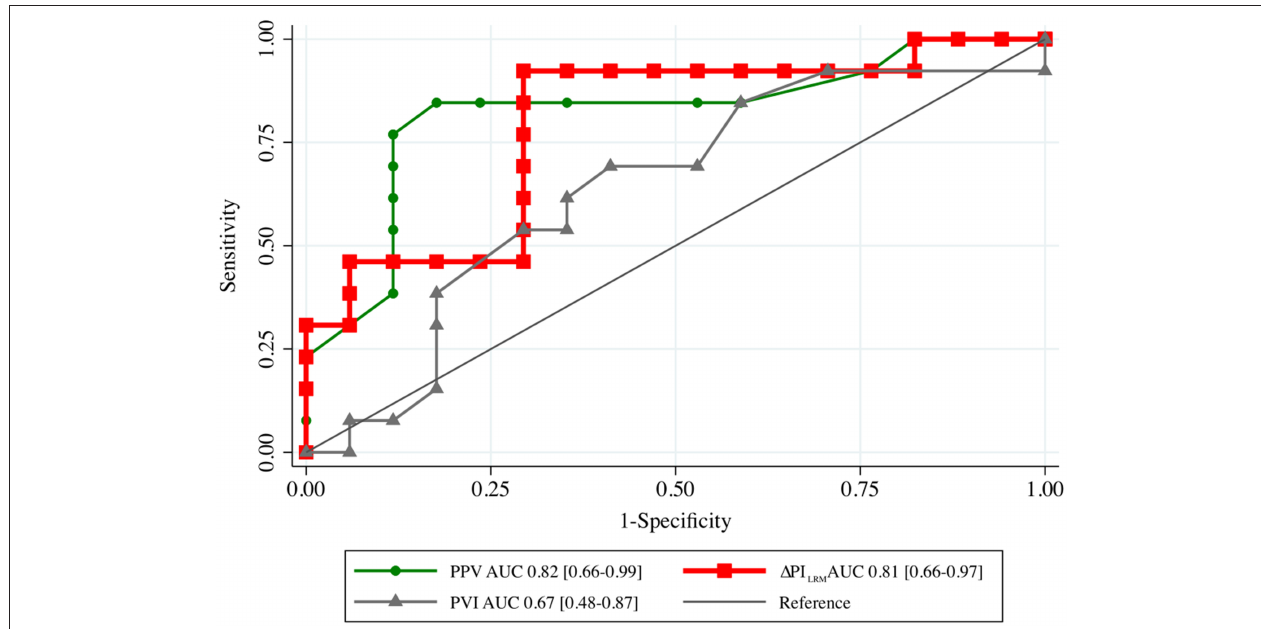
FIGURE 2 | The area under the receiver operating characteristic (AUC) curves generated from the changes in PI following LRM ( 1 PI LRM ), PPV and PVI before lung recruitment maneuver (T1) to predict fluid responsiveness. LRM, lung recruitment maneuver; PPV, pulse pressure variation; PVI, pleth variation